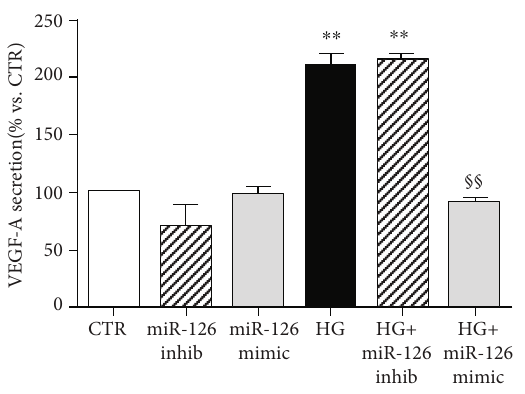
Figure 5: VEGF-A secretion measured by ELISA analysis. Data are presented as the mean ± SEM of three experiments ( n = 3 ). ∗∗ p < 0 : 01 vs. CTR; $§ p < 0 : 01 HG+mimic vs.